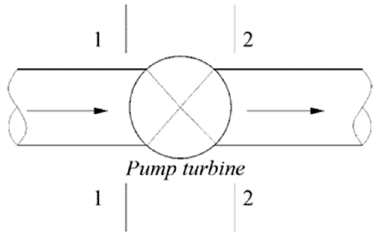
Figure 3. Unit node. Figure 3. Unit